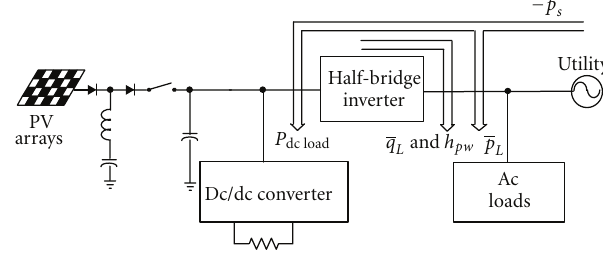
Figure 11: Illustration of power flow during the interval of no insolation.